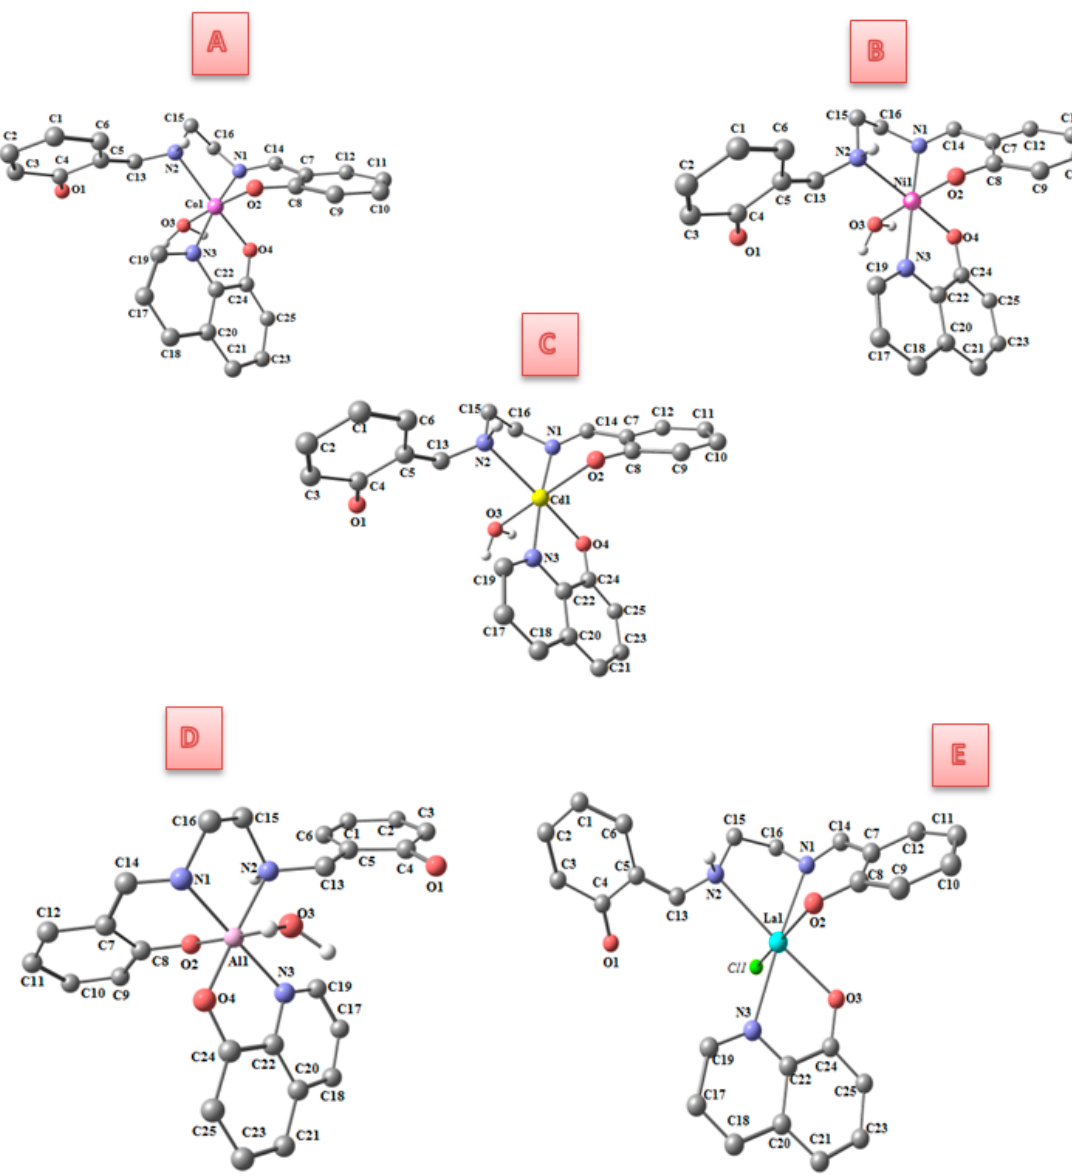
Figure 9. The optimized structure of [Co(S)(Q)(H 2 O)] ( A ), [Ni(S)(Q)(H 2 O)] ( B ), [Cd(S)(Q)(H 2 O)] ( C ), [Al(S)(Q)(H 2 O)] + ( D ), and [La(S)(Q)Cl] ( E ) using B3LYP/LANL2DZ. H atoms on carbon atoms are omitted for clarity.